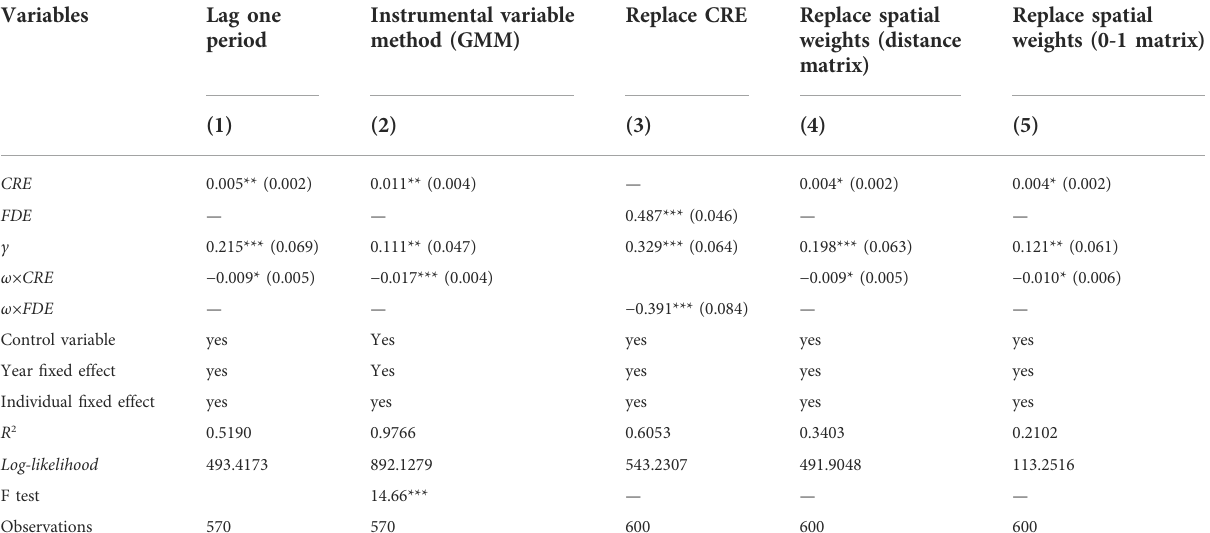
TABLE 6 Robustness test